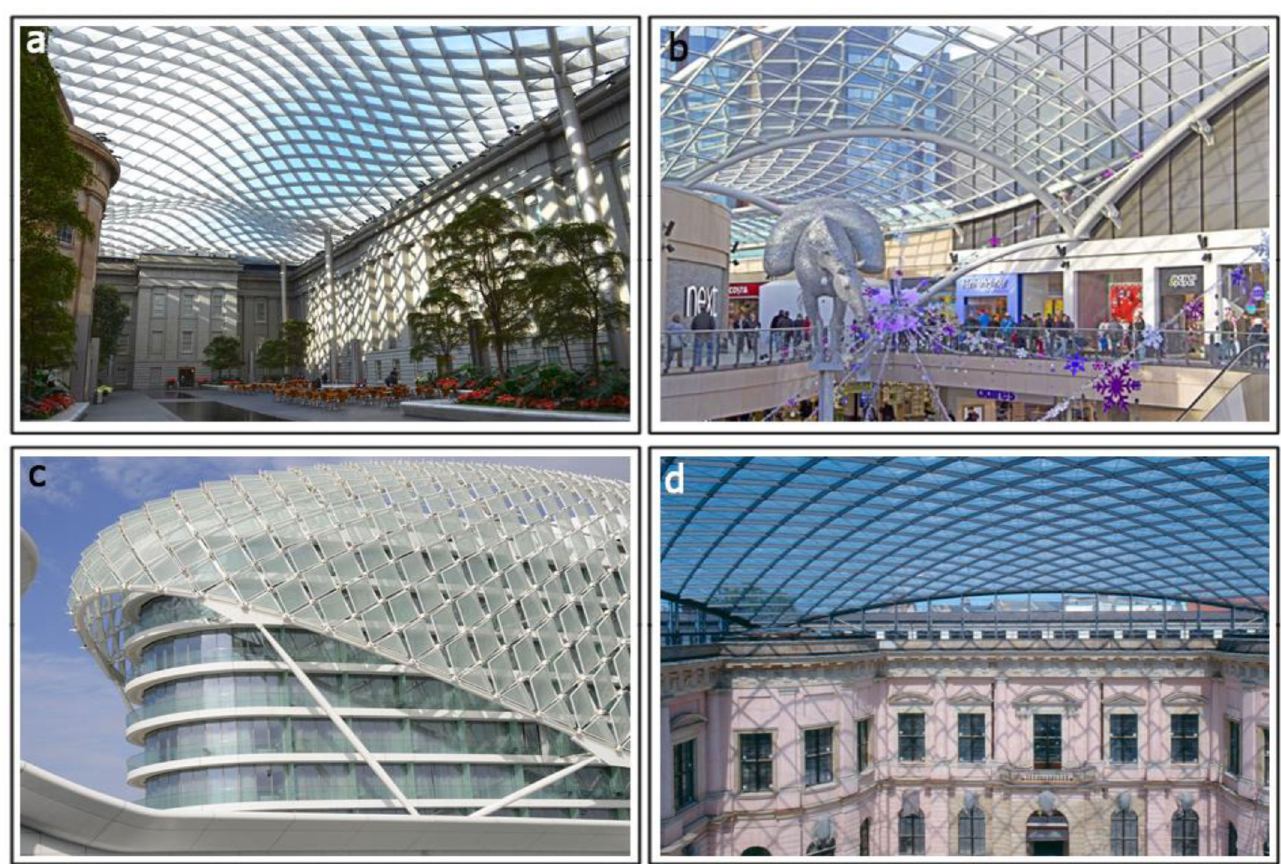
Figure 2. Curvilinear grid-shell canopy with rectangular mesh panelisation: ( a ) Kogod Courtyard w Smithsonian; ( b ) Trinity w Leed mall centre; ( c ) Yas Island Hotel in Abu Dhabi; ( d ) German Historical Museum in